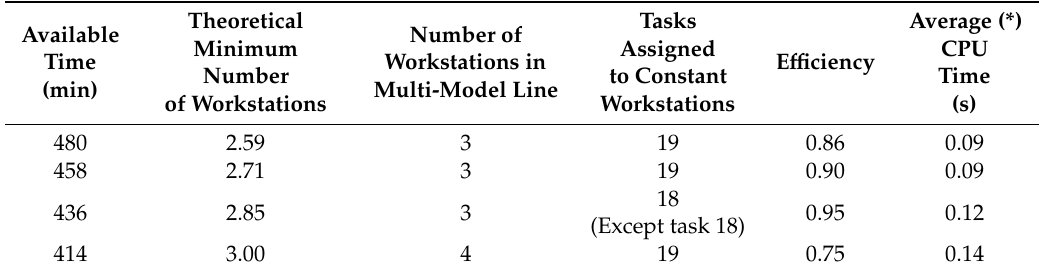
Table 12. Results of the computational experience with an instance from [29].